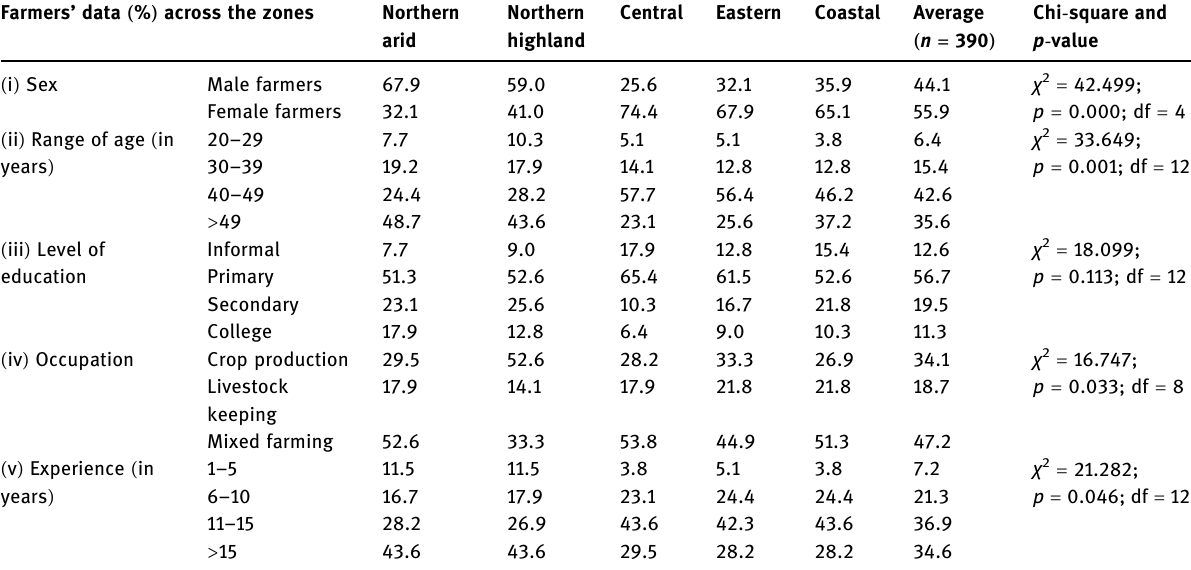
Table 3: Households ’ demographic data from fi ve Lablab agro - ecological production zones Farmers ’ data ( % ) across the